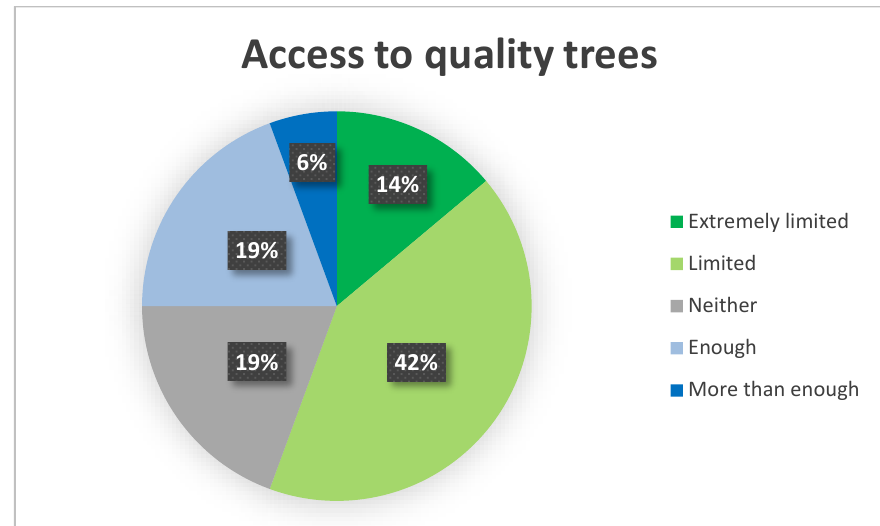
Figure 2. Industry ratings of access to avocado trees.